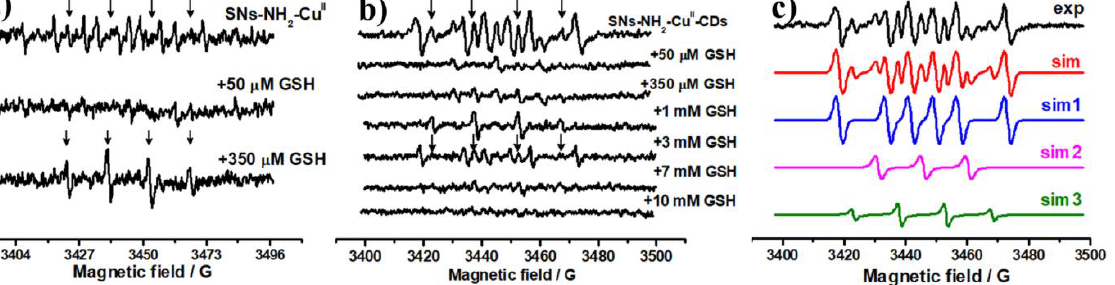
Figure 4. ESR signals of aqueous dispersions of SNs-NH 2 -Cu II ( a ) and SNs-NH 2 -Cu II -CDs ( b ) (0.5 gL −1 ; 10 μ M of Cu II ) in the presence of GSH at 50 μ M, 350 μ M, 1 mM, 3 mM, 7 mM and 10 mM with DMPO spin trap (0.1 M); DMPO- OH∙ signal positions are shown by arrows. In addition, experimental (exp) and simulated (sim) ESR signal of Cu II -CDs (10 μ M of Cu II and 0.5 gL −1 of CDs) and SNs-NH 2 -Cu II -CDs colloids ( c ); ESR signal is the interference of DMPO- X∙ spin -adducts (sim1), an oxidized DMPO radical (sim2) and DMPO- OH∙ spin -adducts (sim3). The experimental spectra were recorded at 38 °C.